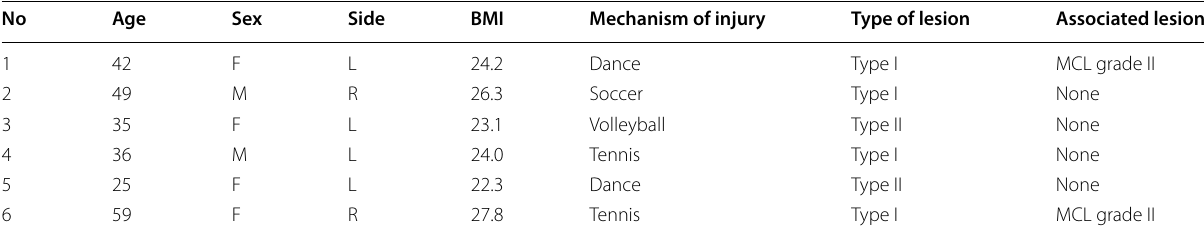
Abbreviations : F , female, M , male, MCL , medial collateral